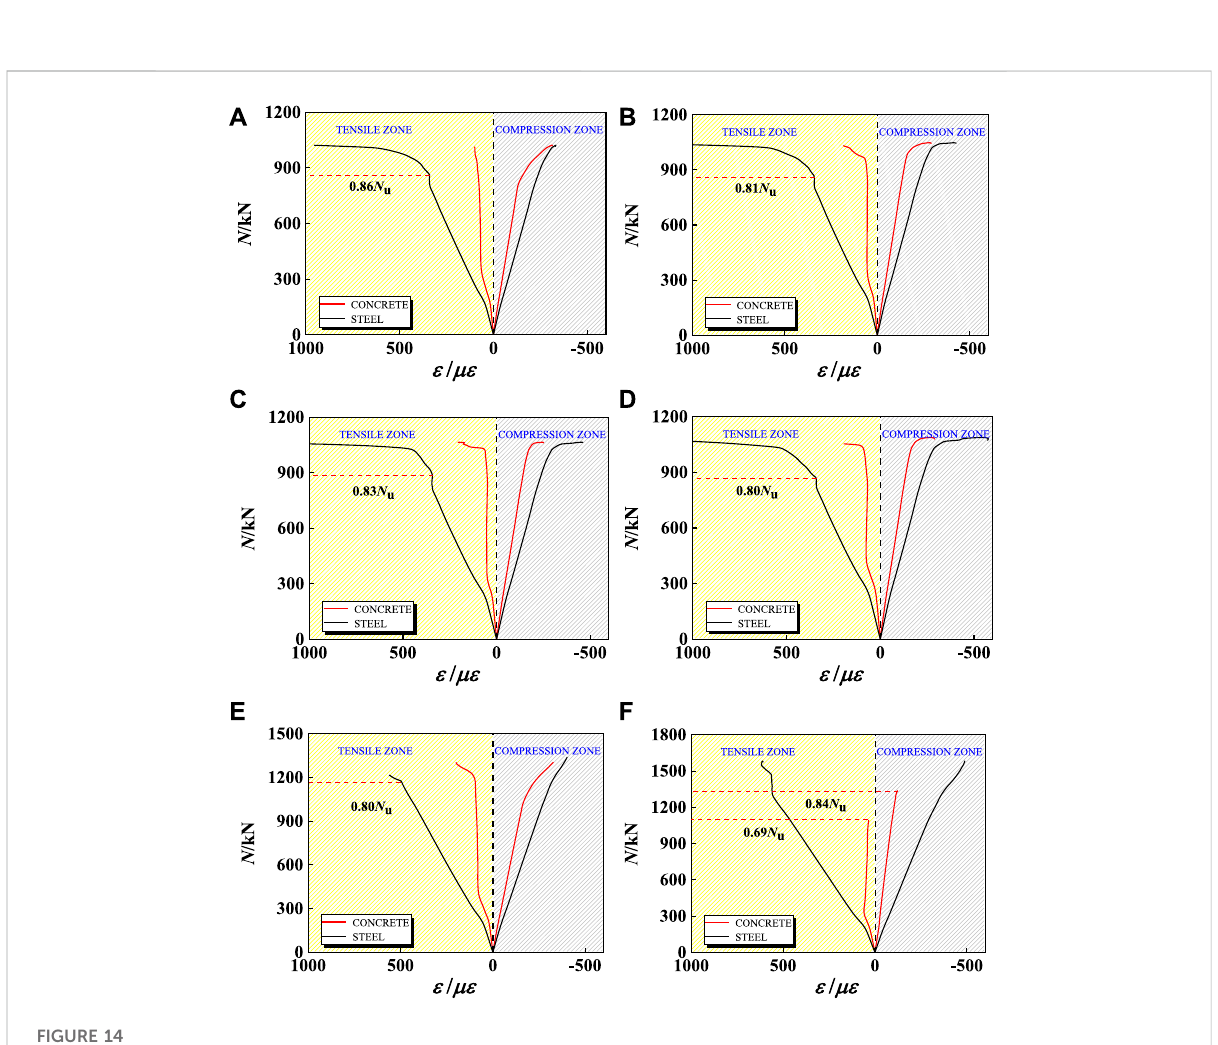
FIGURE 14 Load-strain curves of concrete and steel tube: (A) SHC1; (B) SHC2; (C) SHC3; (D) SHC4; (E) SHC5; (F) SHC6; (G) SHC7; (H) SHC8; (I) SHC9; (J) SHC10; (K) SHC11; (L) SHC13; (M) SHC14; (N) SHC16; (O) SHC18; (P) SHC19; (Q) SHC23.